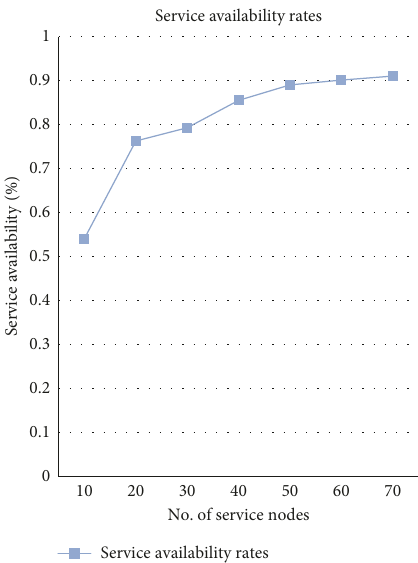
Figure 6: Service selection effect on web service